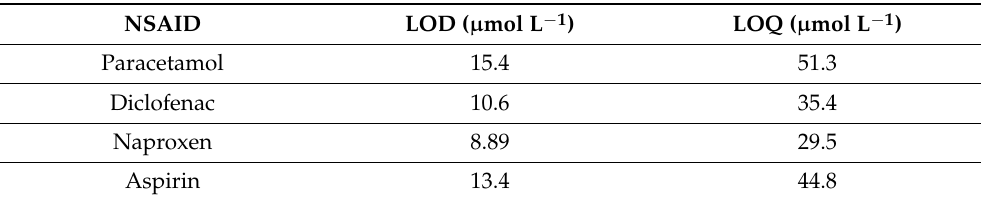
Table 3. LOD and LOQ evaluated the MWCNT-CPE for the testing stage using an MLP architecture with two hidden layers.